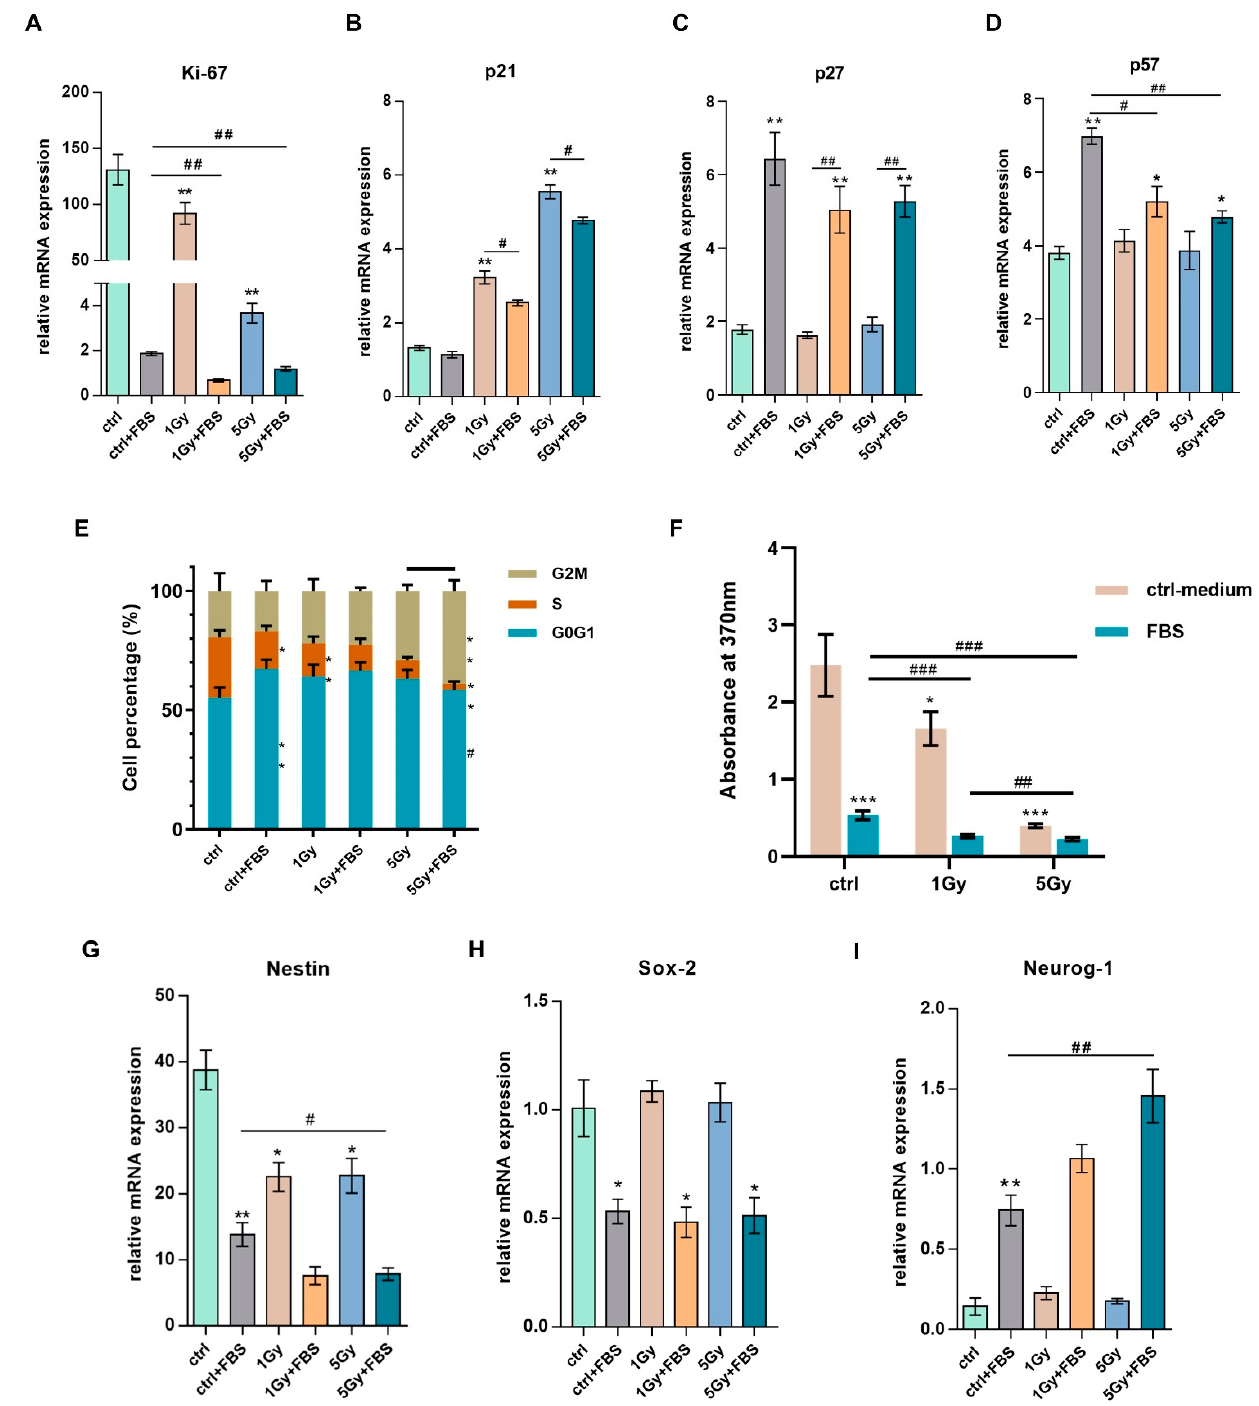
Figure 3. IR impacted NSC proliferation and their cell cycle. ( A – D ) Representations of the relative mRNA expression of proliferation markers of NSCs under different treatments. ( E ) A histogram represents the percentage of NSCs in the different phases of the cell cycle for the indicated treatments. ( F ) A bar graph with absorbance value representing the amount of BrdU incorporated in newly synthesized cellular DNA. ( G – I ) Bar graph showing the relative mRNA expressions of neural progenitor markers of NSCs undergoing different treatments for 24 h. n = 3; Mean ± SEM. * p < 0.05, ** p < 0.01, *** p < 0.001 as compared with the control; # p < 0.05, ## p < 0.01, ### p < 0.001 for comparisons between indicated groups.